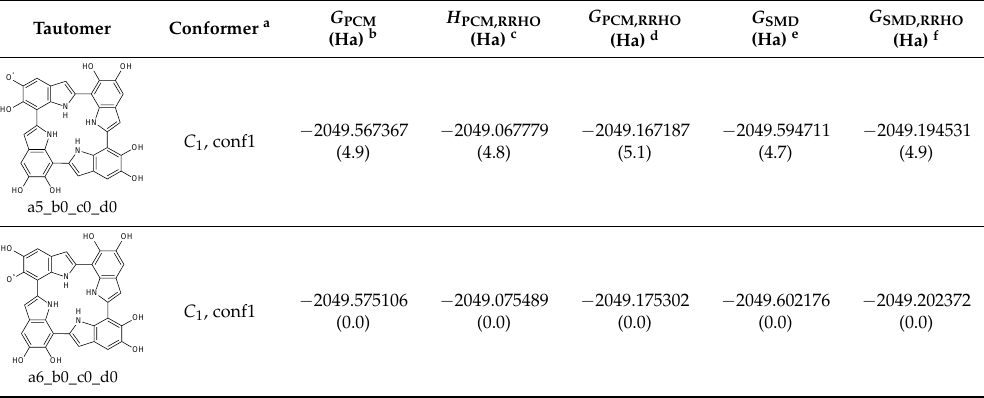
Table 5. KP-1e, neutral form in water.